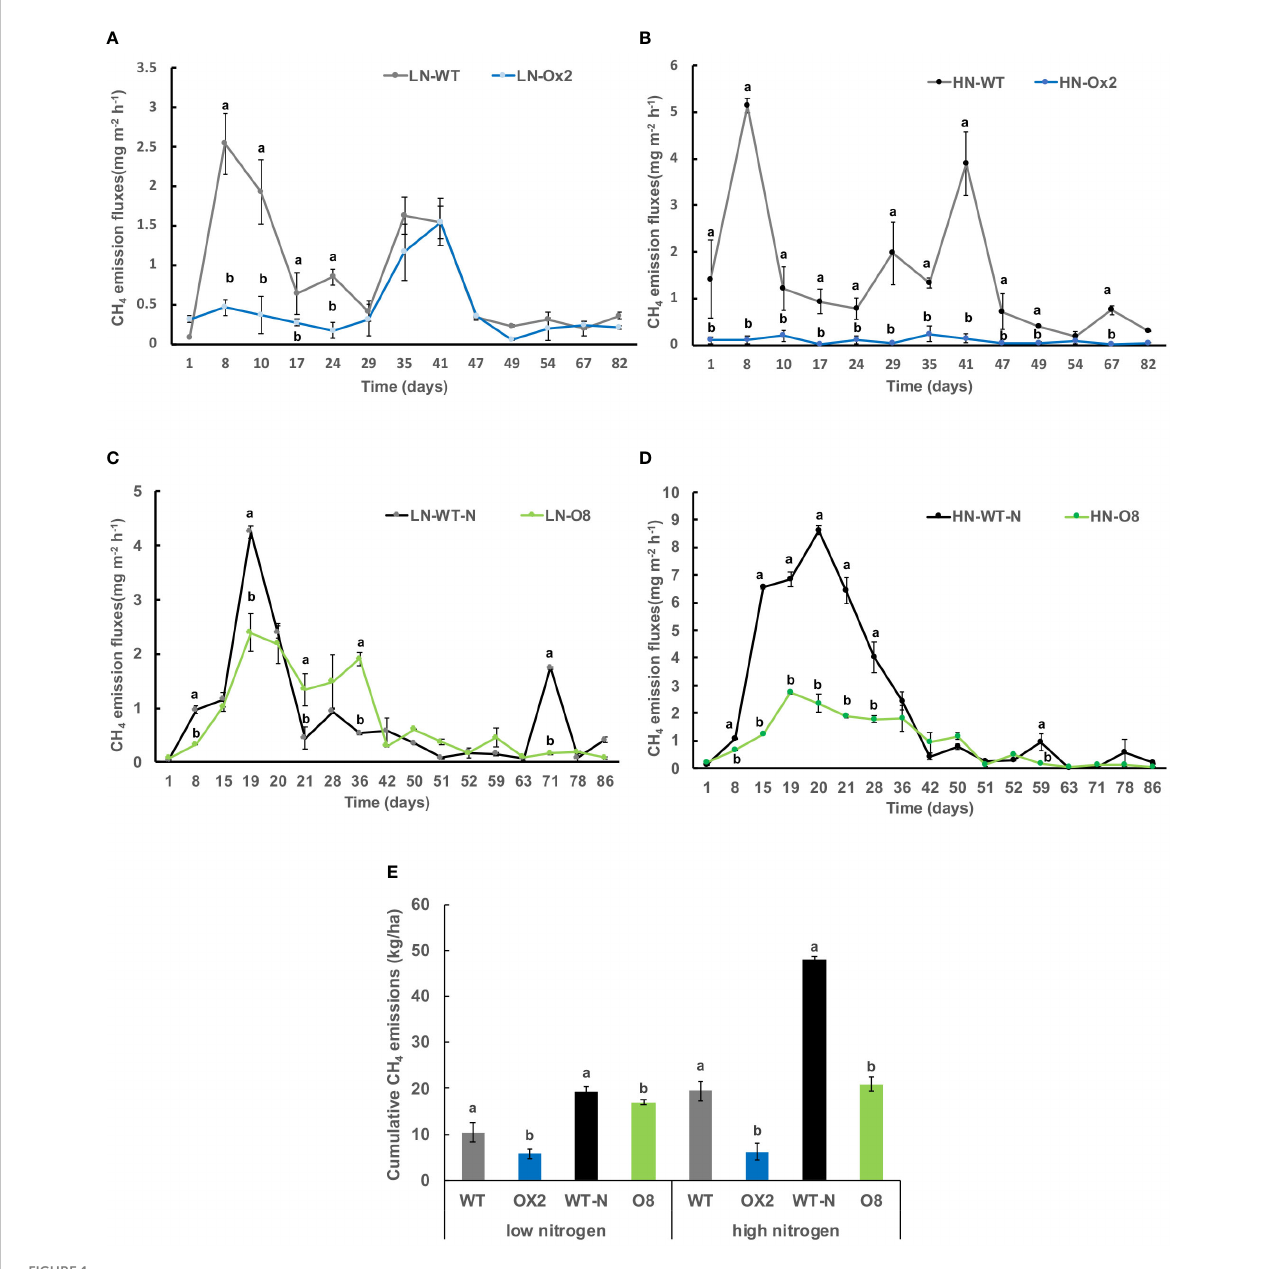
FIGURE 1 Detailed CH 4 gas emission fl uxes (mgm -2 h -1 ) from rhizosphere of WT, Ox2, WT-N and O8. The (LN) low nitrogen soil application shows in fi gure (A, C) and (HN) high nitrogen soil application shows in fi gure (B, D) . X-axis shows CH 4 gas emission recording time (days), from the fi rst measurement after transplanting seedlings from nursery to fi eld is day1 to onwards (A-D) . CH 4 emission fl ux (mgm -2 h -1 ) from the rhizosphere was compared between Ox2 in fi gures a-b and O8 in fi gure (C, D) with their respective wildtypes (WT) separately. Figure (E) shows cumulative CH 4 emission during full growing season in kilogram per hectare (kg/ha). Cumulative emission data consist of 13 individual values taken during various growth stages (n=13). Error bars: SE (n = 3). Signi fi cant difference between two cultivars (transgenic and respective WT) are indicated by different letters: a= high value, b= lower value ( t -test, p<